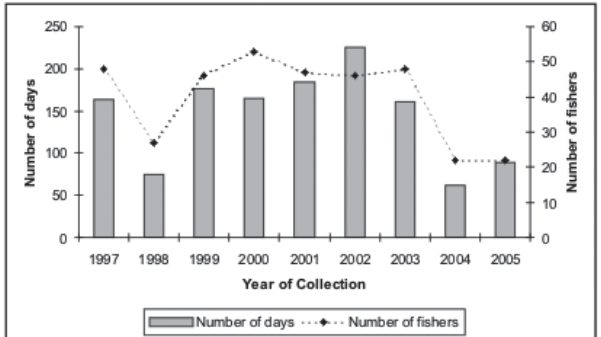
Fig. 5. Number of days of collection and number of fishers involved in the syngnathid fishery in Salvador, Bahia, Brazil, from January/1997 to